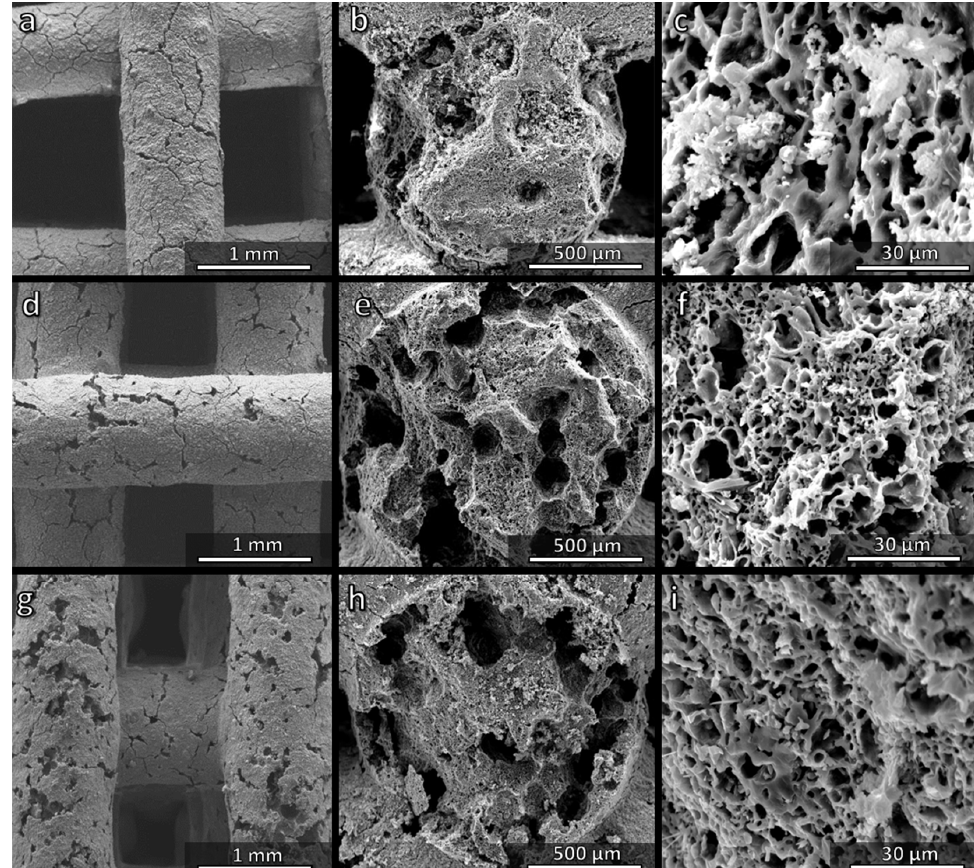
Figure 9. Comparison of the microstructure of Biosilicate ® -like scaffolds fired in air prepared from H44-based inks com- prising anhydrous sodium phosphate: ( a – c ) without low temperature heating step; ( d – f ) pre-heated at 60 °C; ( g – i ) pre- H44-based inks comprising anhydrous sodium phosphate: ( a – c ) without low temperature heating heat at 75 °C . step; ( d – f ) pre-heated at 60 ◦ C; ( g – i ) pre-heat at 75 ◦